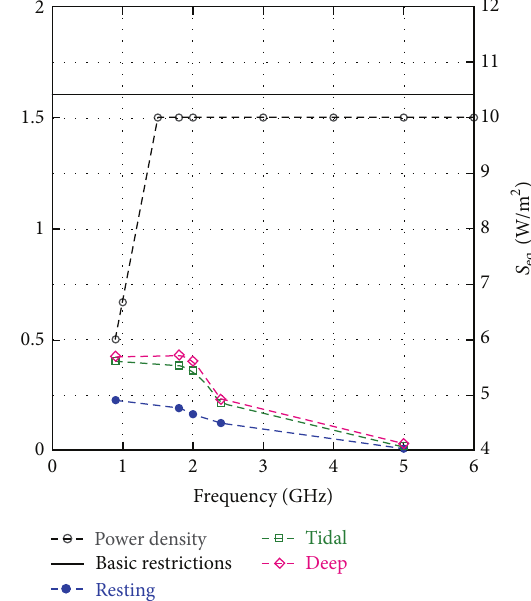
Figure 7: SAR 1 for the RS, TB, and DB models for FCC reference -g levels. The FCC power density reference level allowed for general population is also reported.